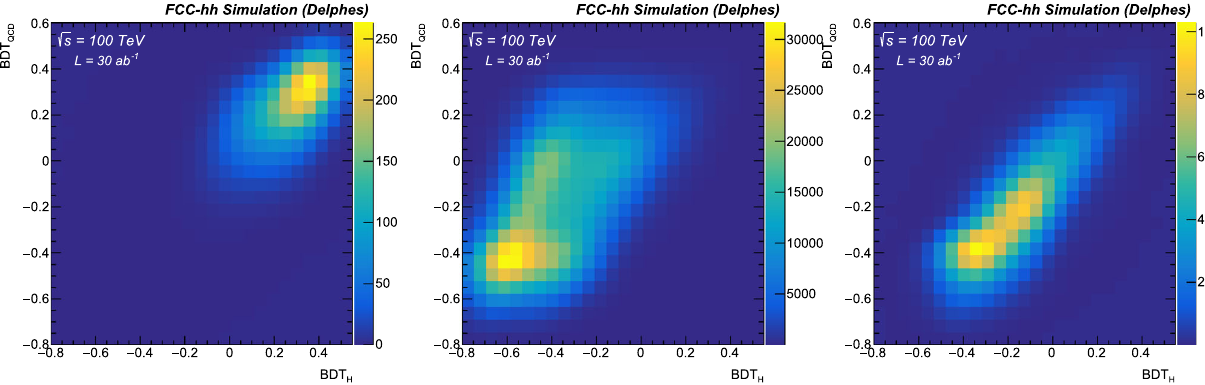
Fig. 6 Spectrum of SM signal ( a ), the QCD ( b ) and single Higgs ( c ) backgrounds in the (BDT H ,BDT QCD ) plane